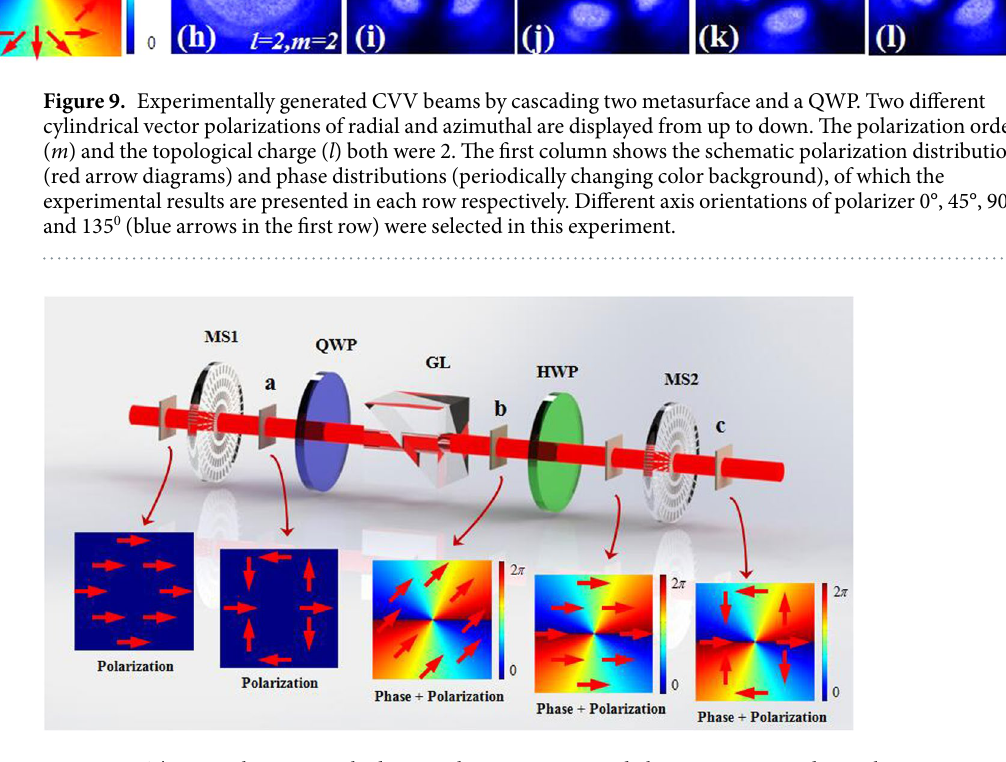
After passing through a QWP with the fast axis was parallel to the horizontal axis, and an analyzer which was rotated to + 45 0 , the output wave at point b can be written as π π = π π A HWP was used to rotate the polarization state to horizontal. So, after another metasurface with the q-value of q